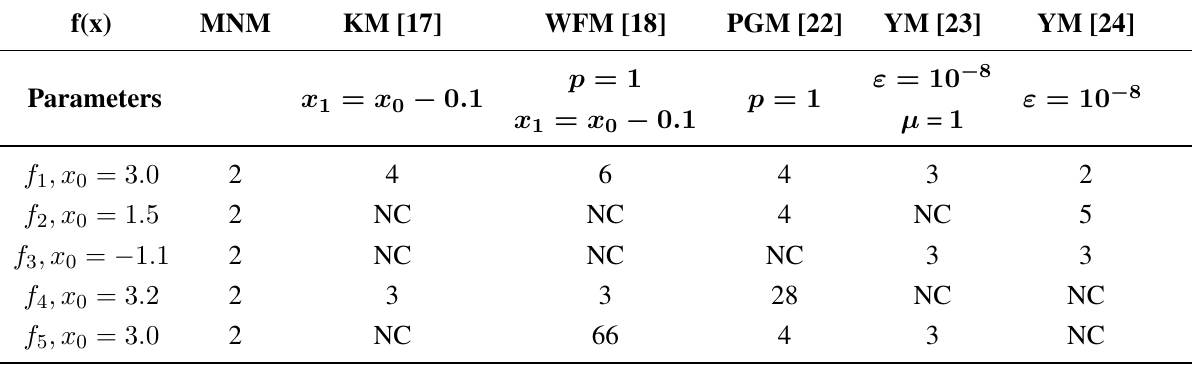
Table 1. Comparison of various aiterative methods for the case of single